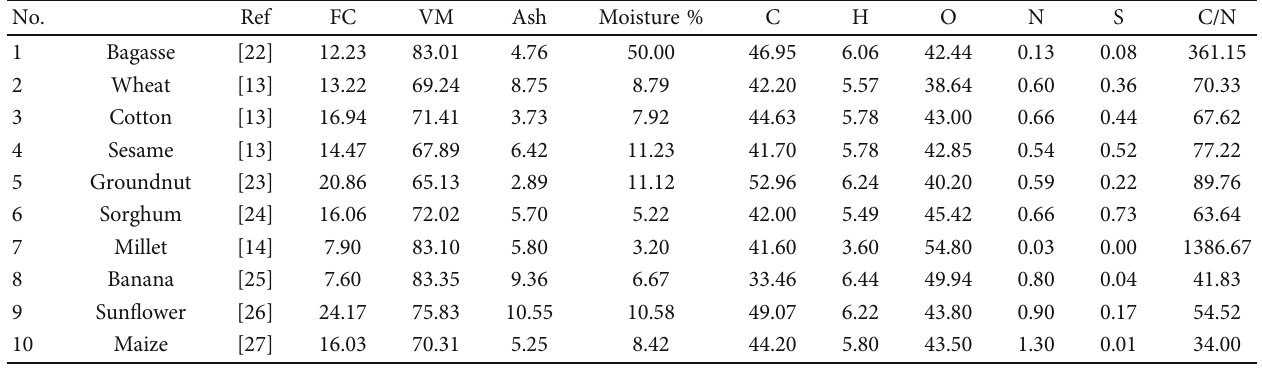
Table 3: Biomass proximate and ultimate analysis.